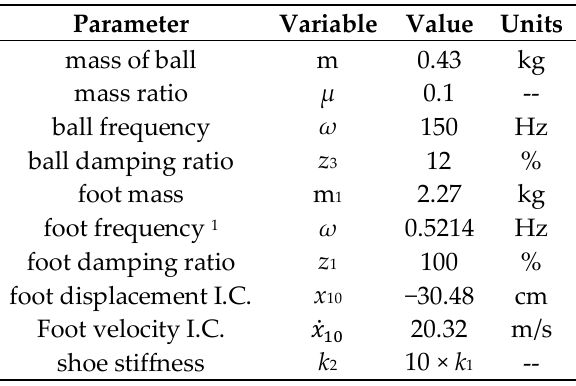
Table 1. Values for football